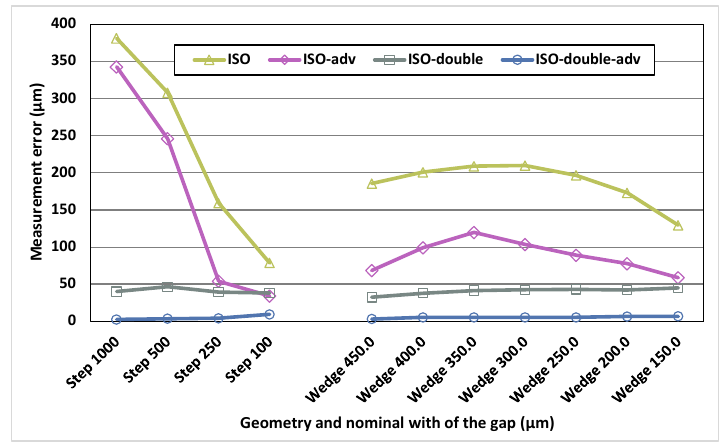
Figure 4. Measurement error results for the Al/Ti multi-material standard of the four threshold-based algorithms provided by VGStudio MAX: ISO, ISO-adv, ISO-double and ISO-double-adv.